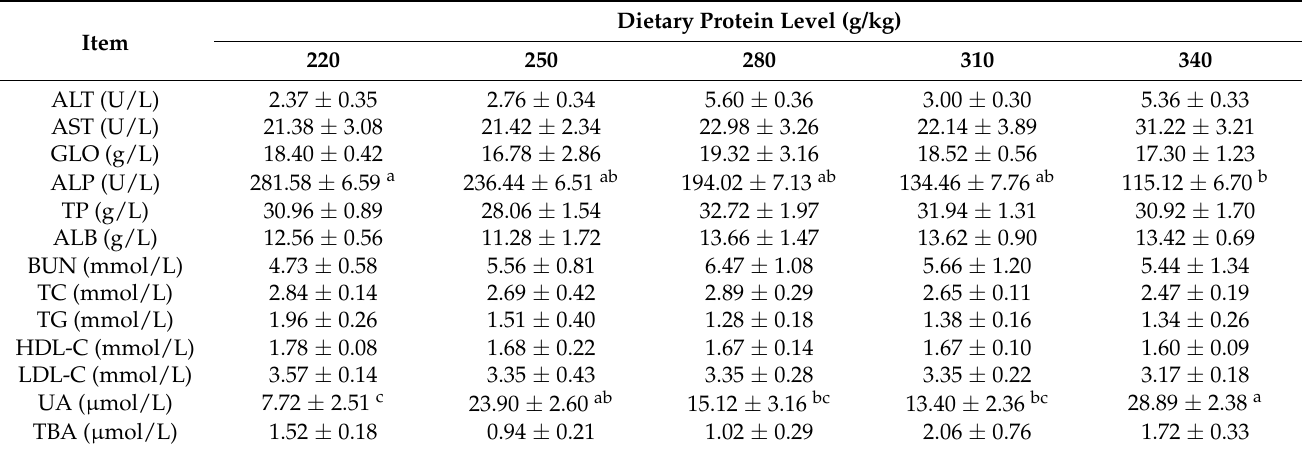
Table 2. Effects of different dietary protein levels on the plasma hematological parameters of Cyprinus carpio haematopterus .